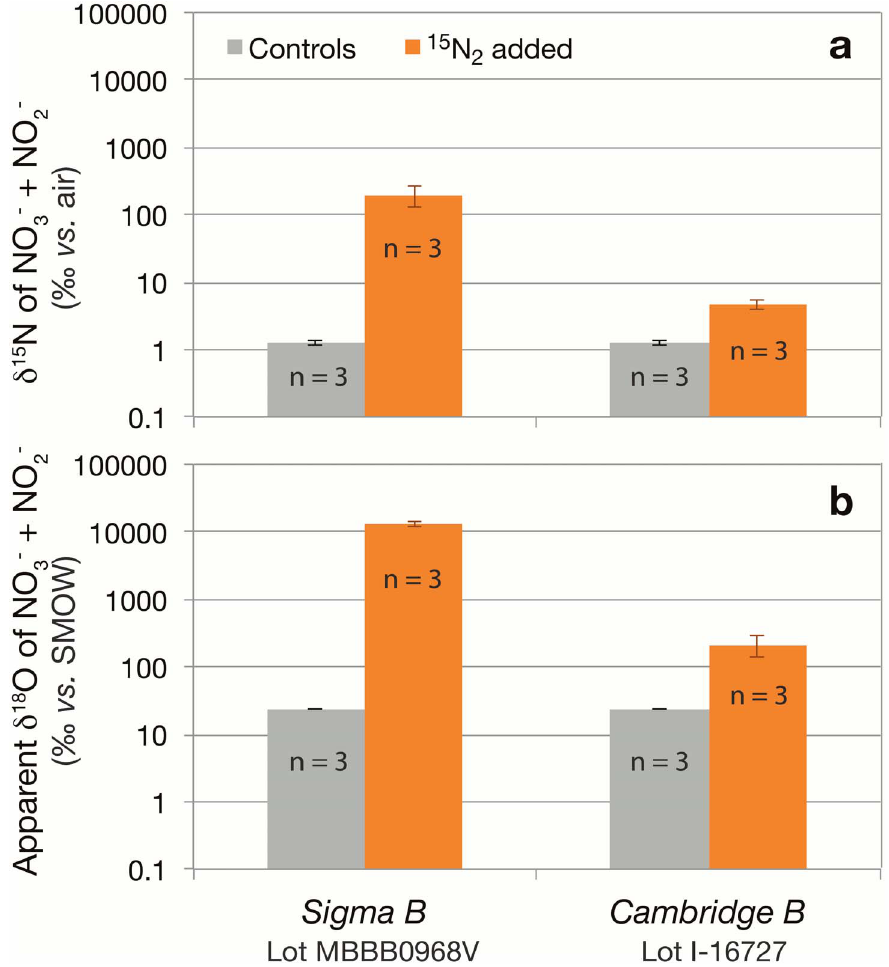
Figure 2. (a) d 15 N NO3 + NO2 (log scale) of higher sensitivity equilibrations of 10 m mol L 2 1 nitrate solutions (10 mL) with 2 mL of 15 N 2 gas from a Cambridge Isotopes or a Sigma-Aldrich bottle. ( b ) Corresponding apparent d 18 O NO3 (log scale) of higher sensitivity equilibrations of the two stocks. n=the number of experimental replicates.